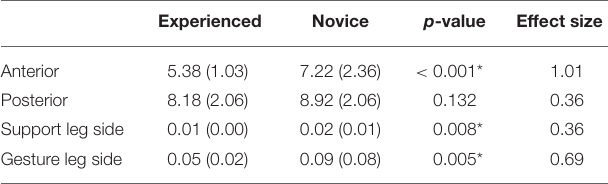
TABLE 3 | Maximum inclination angles during turning phase (degrees).